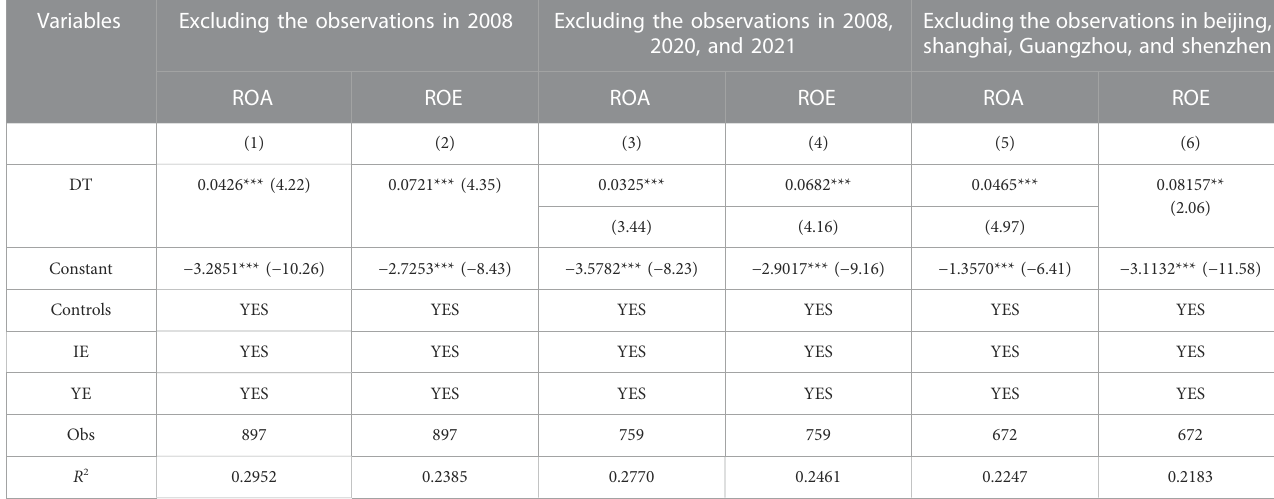
TABLE 3 Robustness check by excluding speci fi c samples. Variables